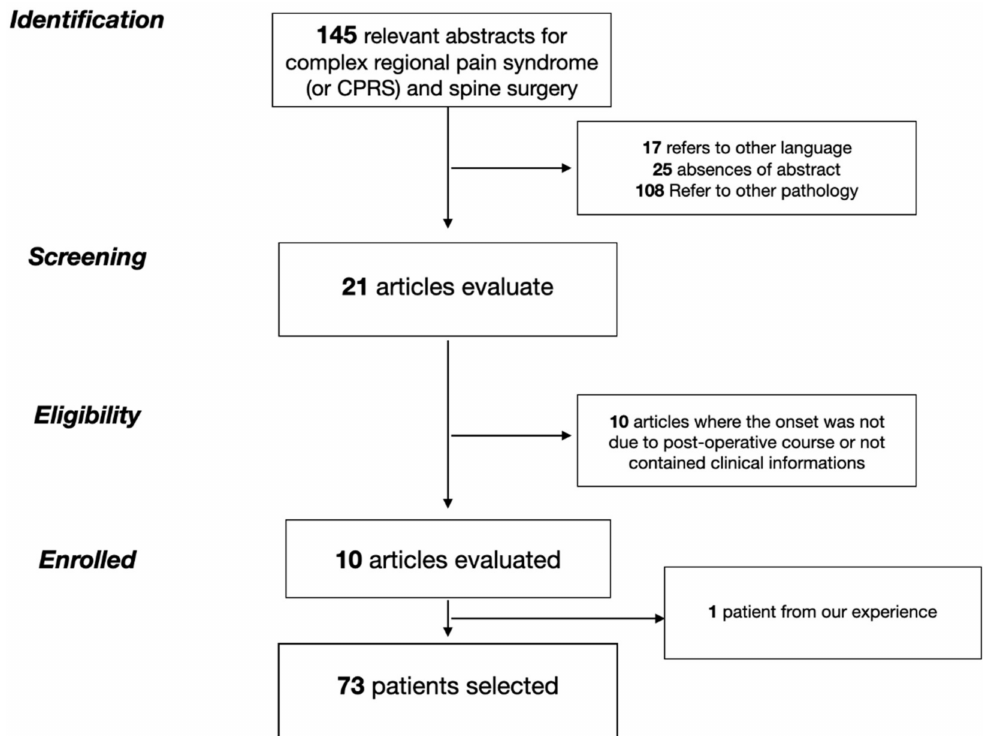
Figure 1. Patient selection